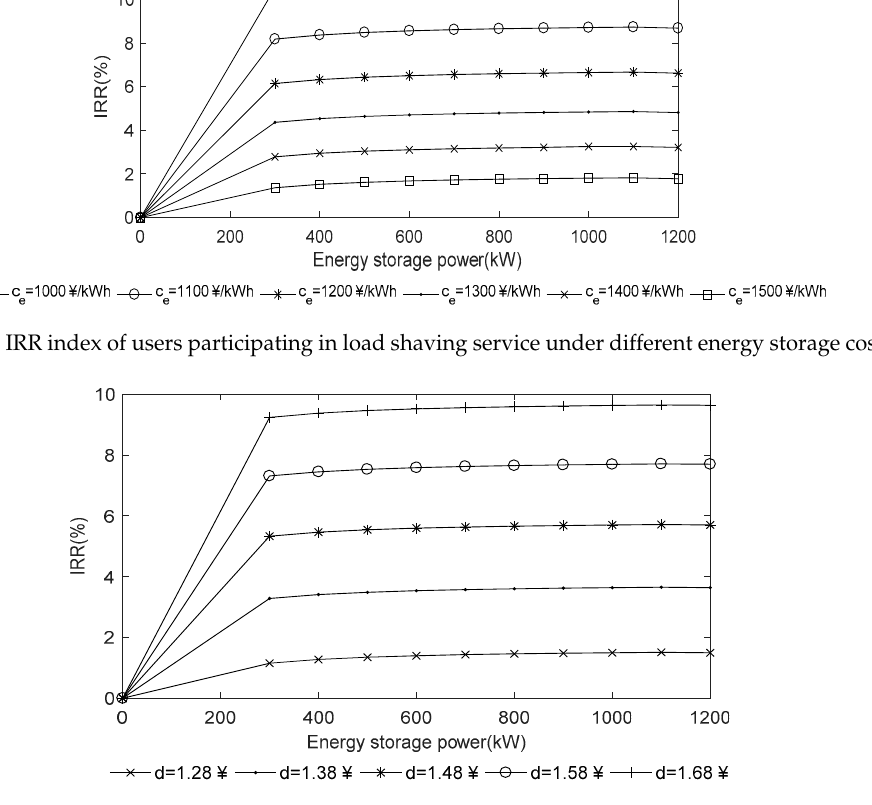
Figure 15. IRR of users participating in load peak shaving service under different peak-to-valley electricity price.